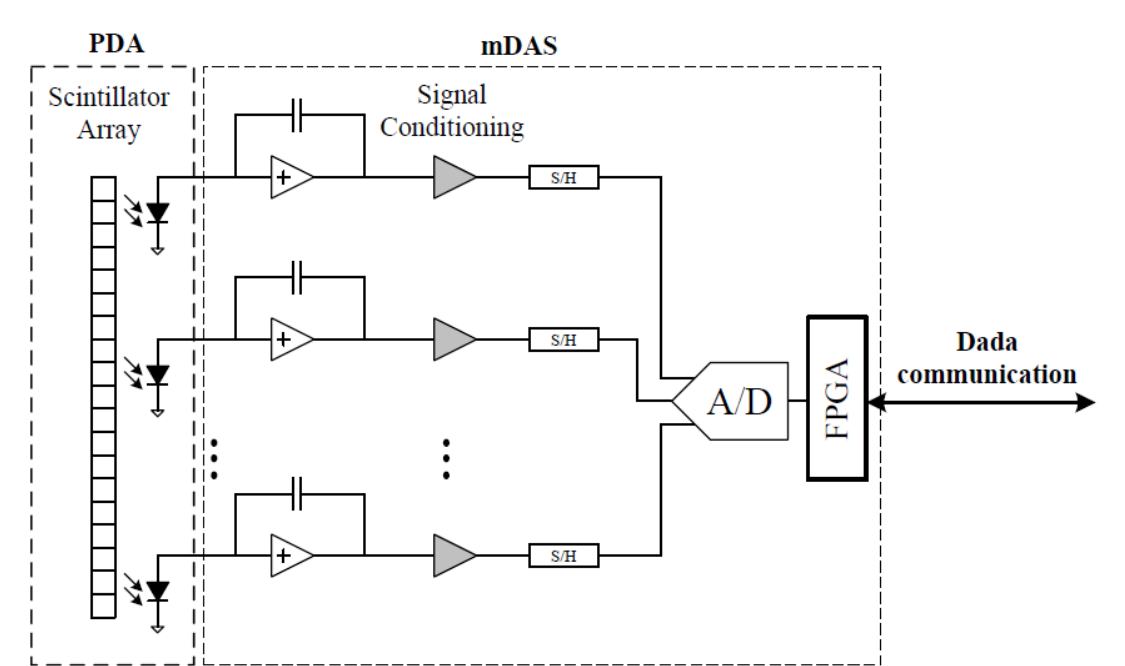
Figure 1. Illustration diagram of the detector